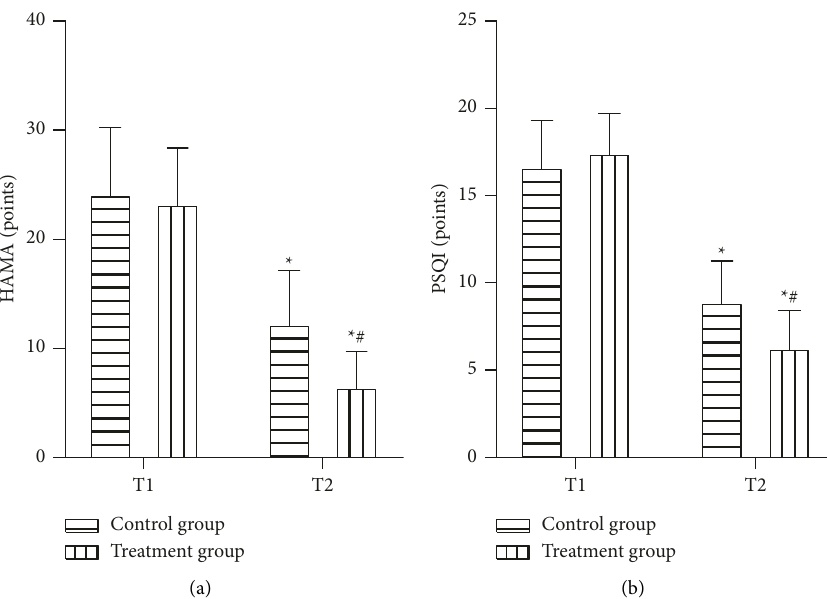
Figure 2: (a) HAMA score and (b) PSQI score. ∗ indicates a significant difference ( P < 0 . 05) between each group compared with the same group at T1. # indicates a significant difference ( P < 0 . 05) between the 2 groups at